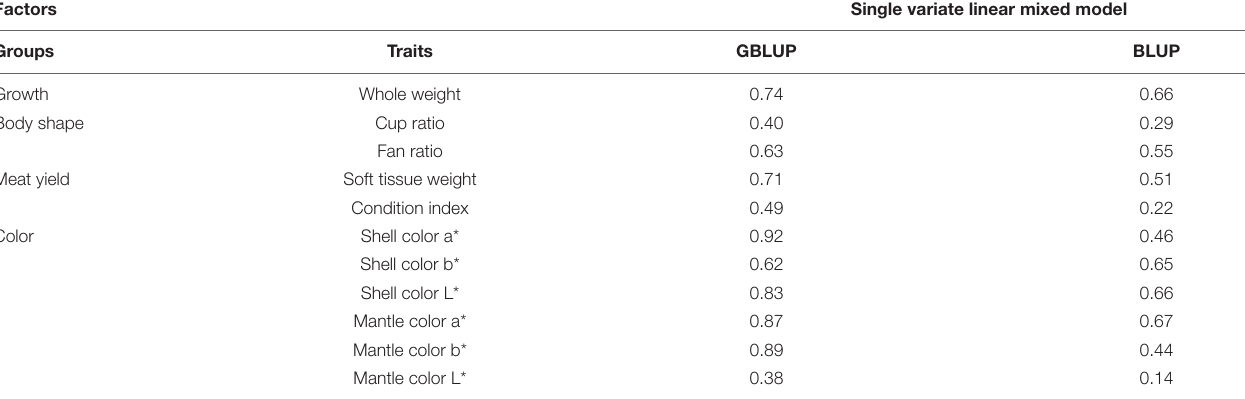
TABLE 3 | Genomic prediction accuracy of the traits with GBLUP and traditional